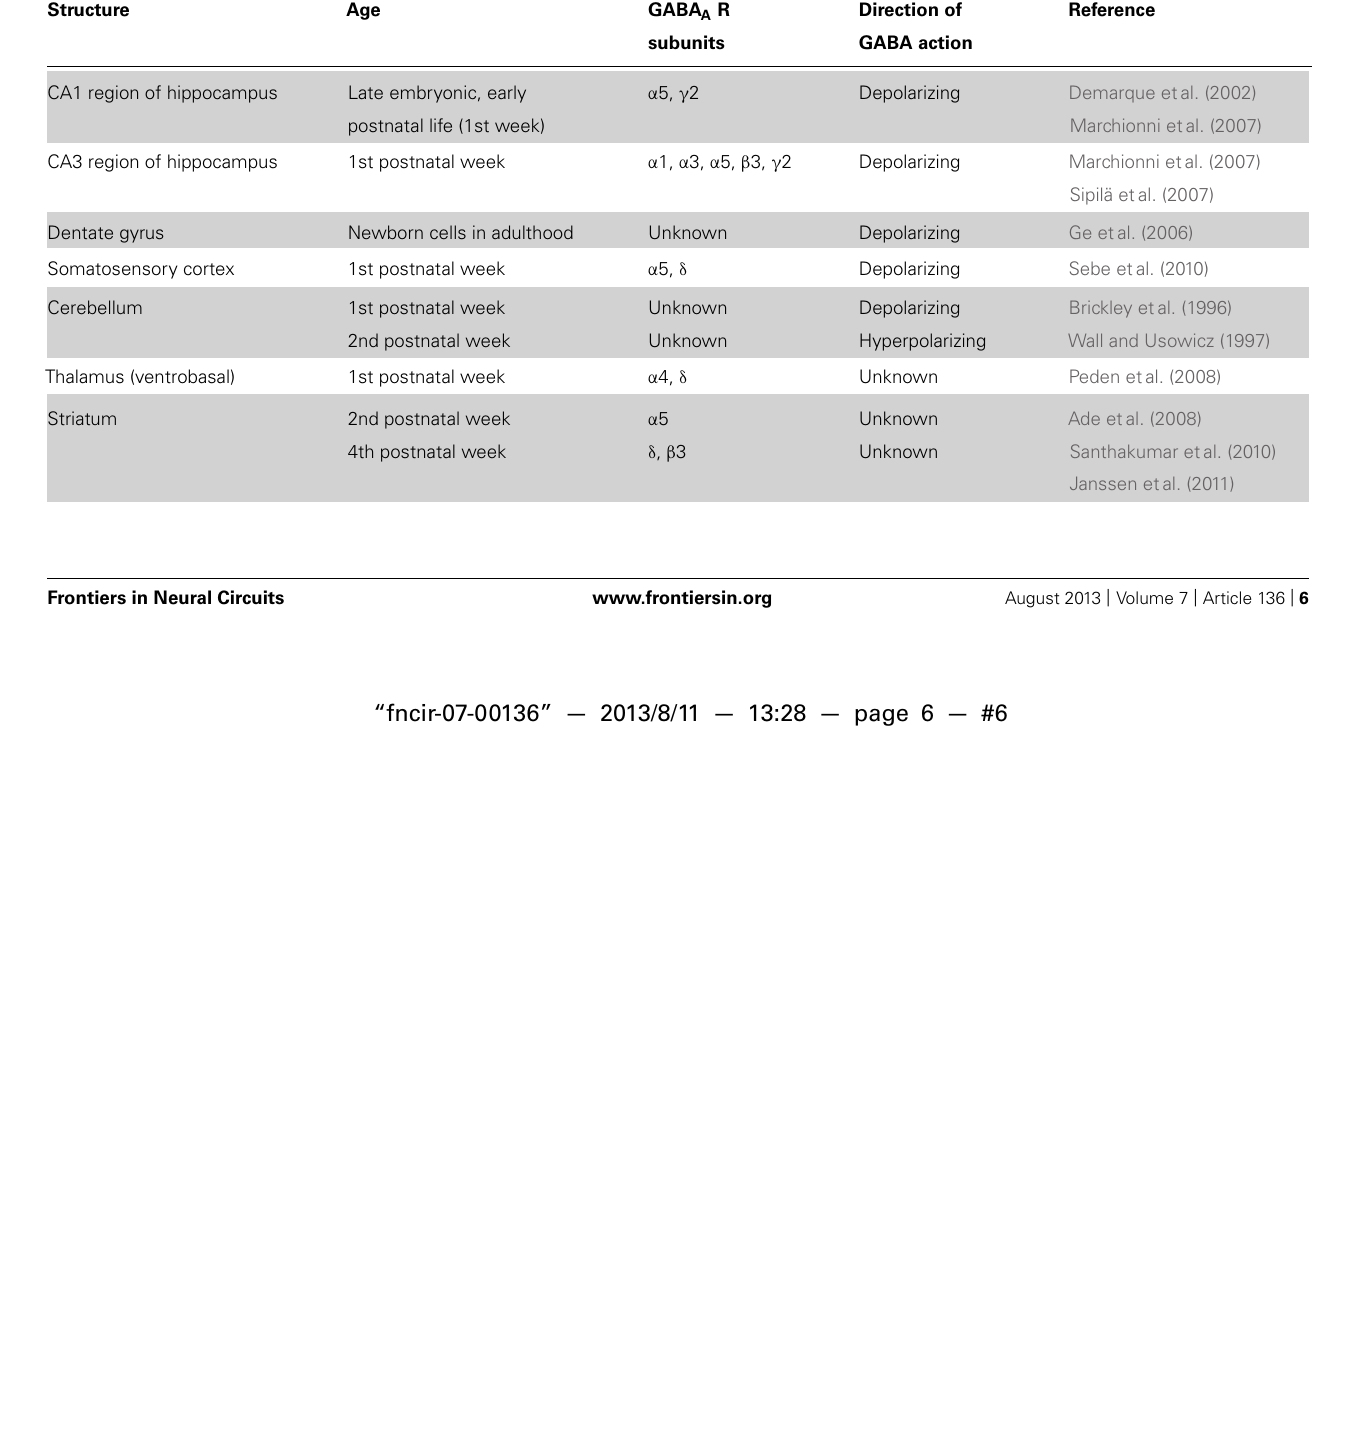
Table 1 |Tonic GABAergic currents in various brain regions during early development.